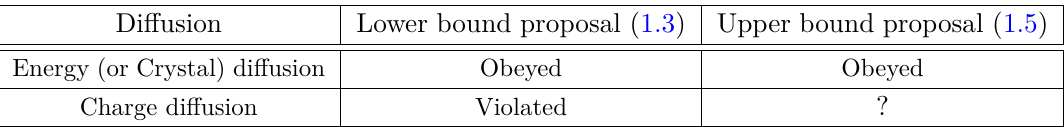
Table 1 . Summary of holographic studies for the bounds of diffusion constants. In this paper, we study the upper bound proposal (1.5) with the charge diffusion